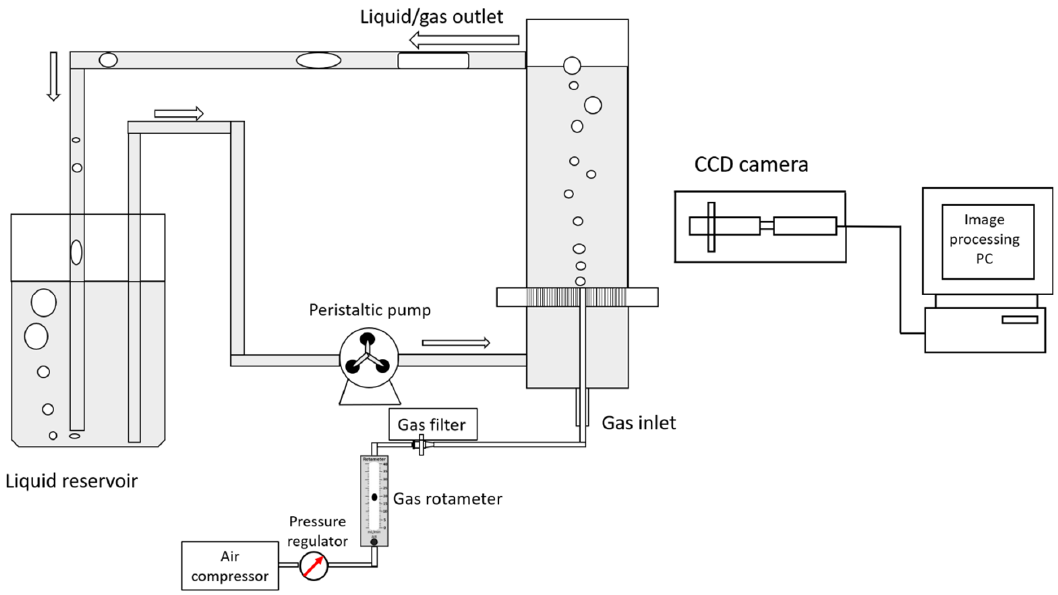
Figure 3. Schematic diagram of the experimental setup for gas–liquid bubble